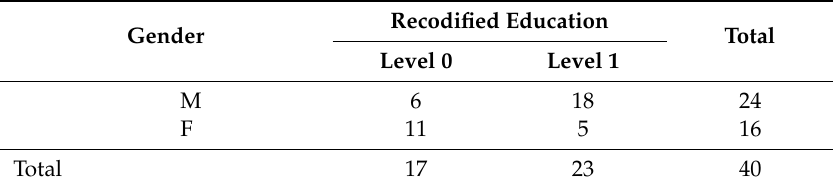
Table 6. Educational level according to